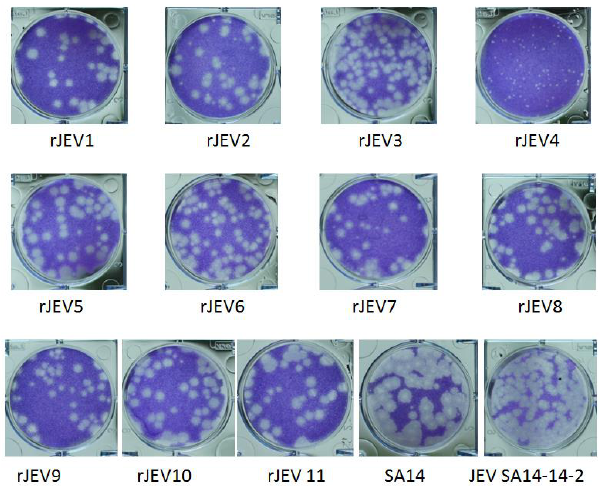
Figure 2. Plaque sizes of the revertants and the control viruses.